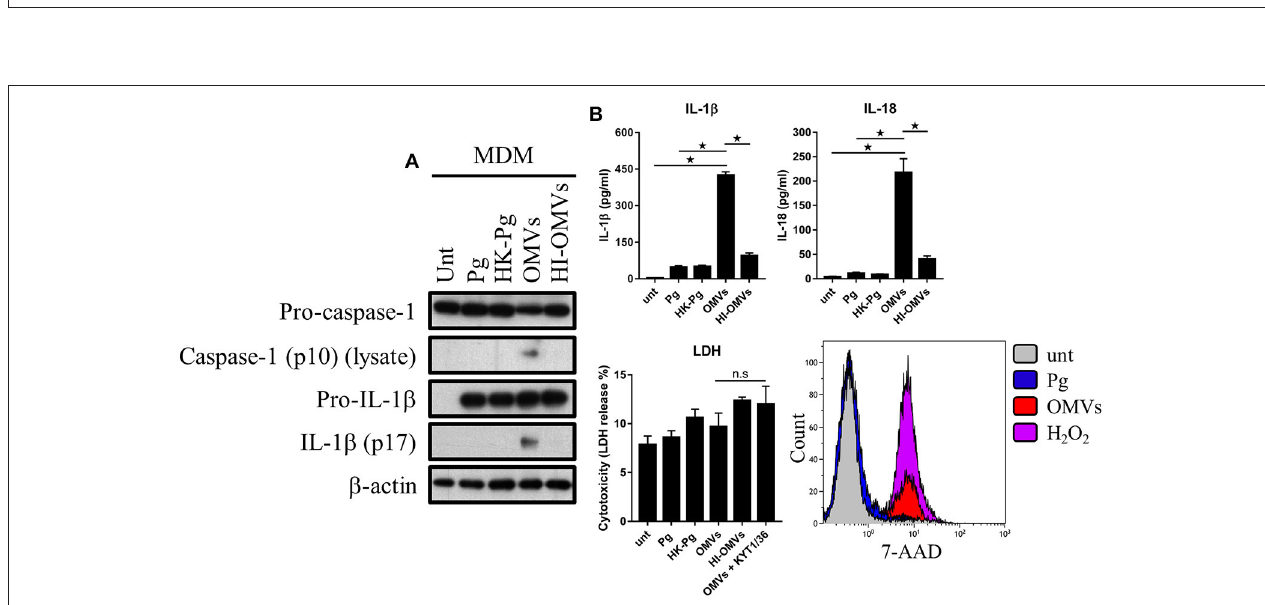
FIGURE 6 | P. gingivalis and its OMVs differentially induce inflammasome signaling and pyroptosis in human macrophages. MDM were infected as before (2 h at MOI of 25:1, see Materials and Methods) with viable P. gingivalis ( Pg ), heat-killed- Pg (HK- Pg ), OMVs, or heat-inactivated-OMVs (HI-OMVs) and (A) the activation of inflammasome components in the lysates was measured after 24 h by Western blot; β -actin serves as a loading control throughout. Western blot data are representative of at least three independent experiments. (B) Production of IL-1 β and IL-18 (by ELISA) from MDM was measured in the supernatant at 24 h. Data are mean ± SD from four independent experiments. Cell viability was determined by measuring extracellular LDH release and by 7-AAD exclusion (by flow-cytometry) at 24 h. 7-AAD is a membrane impermeant dye that is excluded from viable cells. The percent of 7-AAD positive ( ± SD ) cells from three independent experiments was calculated relative to the untreated control. MDM treated with H 2 O 2 (1 mM for 60 min) were included as positive control for 7-AAD. A representative histogram is shown. Cells were also treated where indicated with OMVs in the presence of KYT-1 and KYT-36 (10 µ M of each). * p < 0.05: n.s, not significant.